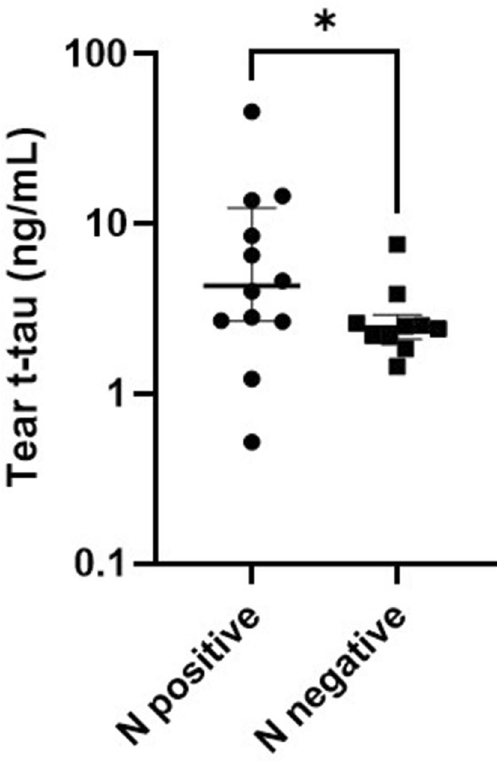
Figure 2. T-tau biomarker levels across ATN groups. Tear t-tau levels in patients with neurodegeneration (N positive) compared to patients without neurodegeneration (N negative). Bars represent median and IQR. P-values were determined using Kruskal–Wallis testing including Bonferroni correction. *p < 0.05.